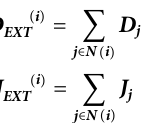
Frontiers in Molecular Biosciences |